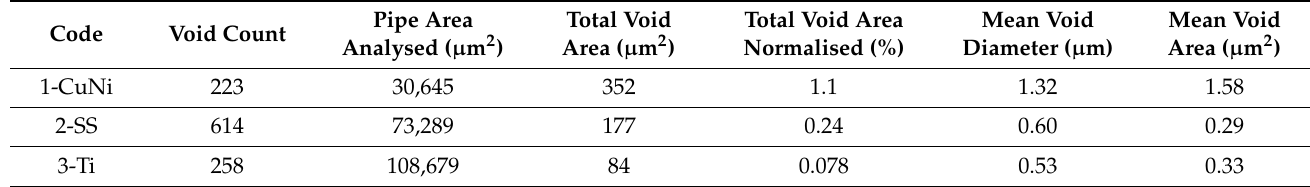
Table 7. Void size quantification for the three uncoated